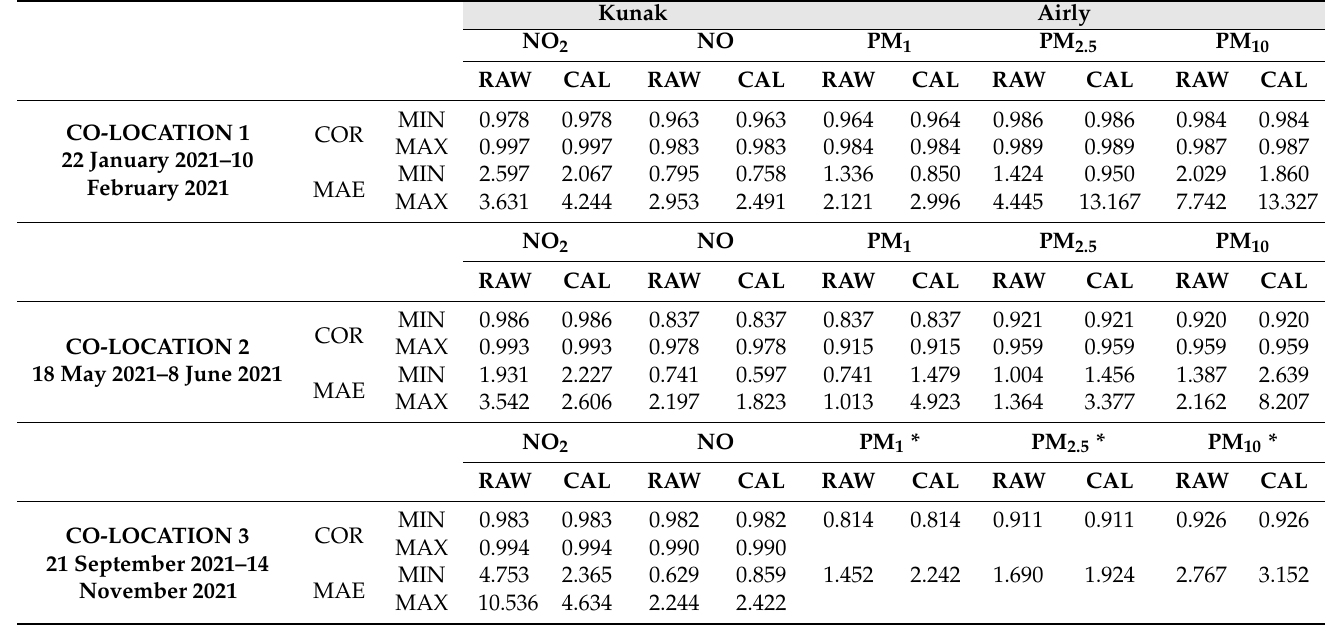
Table 3. Minimum and Maximum Pearson correlations (COR) and Mean Absolute Errors (MAEs) between the considered sensor units for NO 2 , NO, PM 1 , PM 2.5 and PM 10 before (RAW) and after (CAL) local re-calibration.* During the final co-location, only two Airly sensors were available.